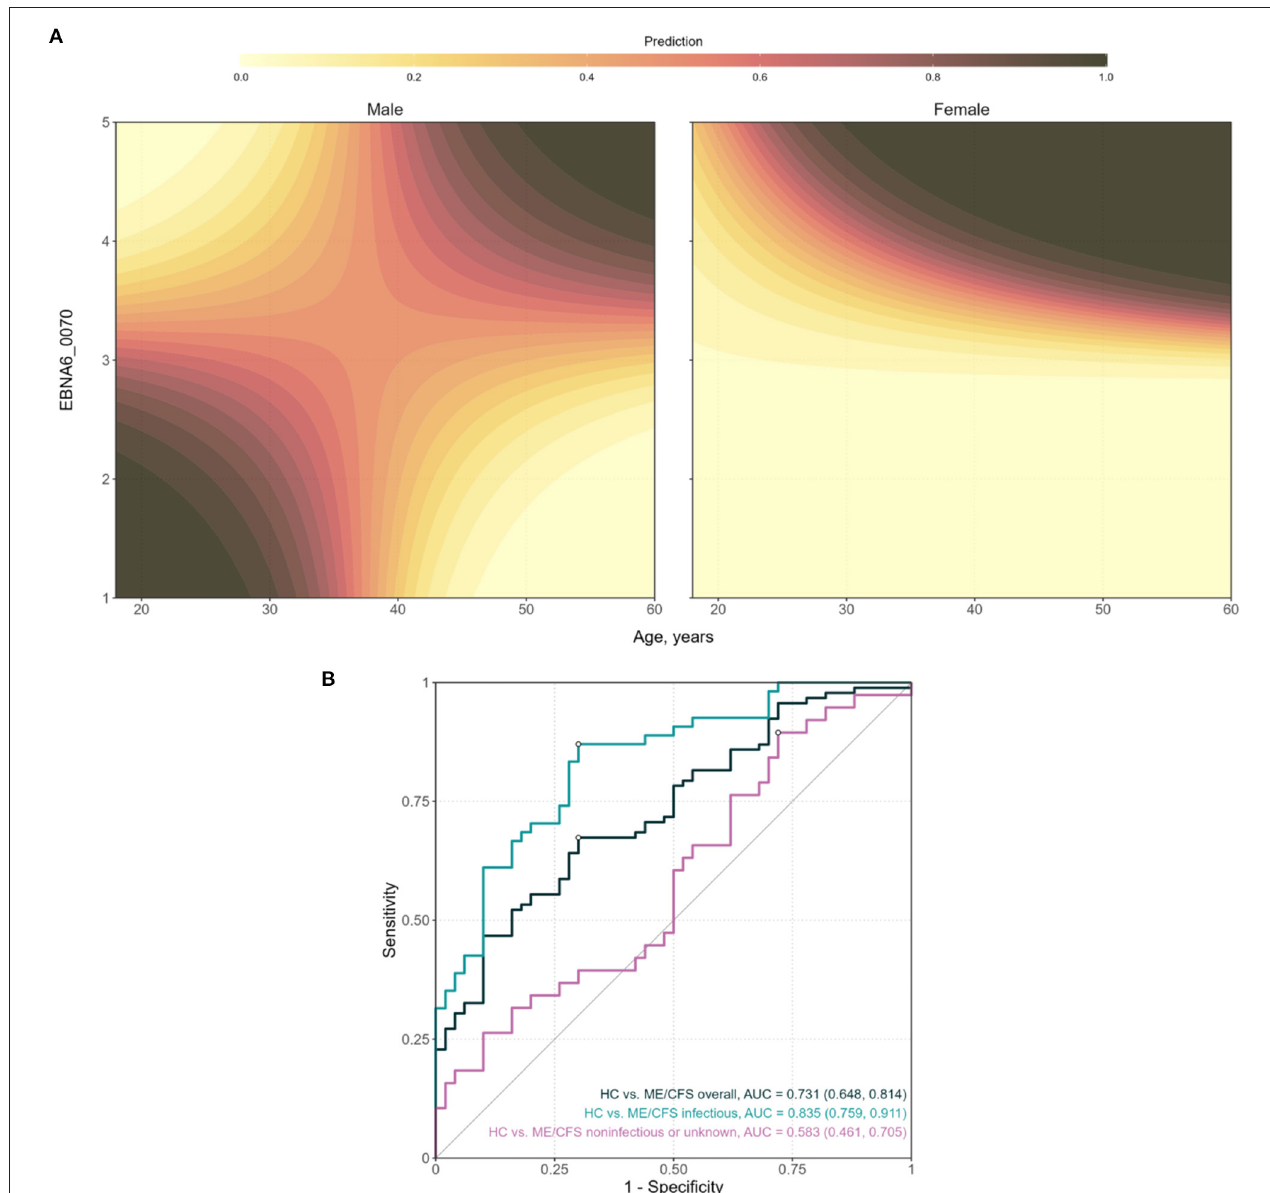
FIGURE 4 | Analysis of the final classification model for predicting ME/CFS patients with an infectious trigger when compared to healthy controls. (A) Contour plots of the probability of being a patient as a function of age and EBNA6_0070 antibody levels, for men and women, respectively. The prediction values were calculated by fixing log 10 (EBNA4_0529) at the respective mean value. (B) ROC curves and the respective AUC (95% confidence interval shown within brackets) when using the model to compare different groups of ME/CFS patients to healthy